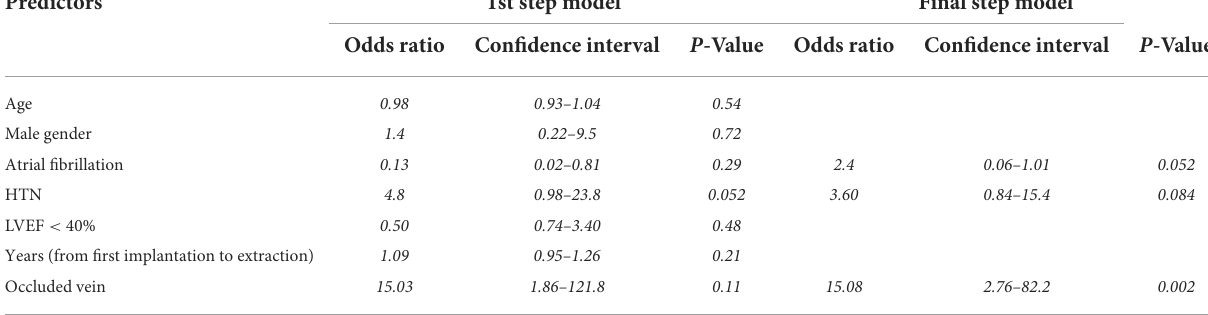
TABLE 5 Multivariable regression (backward Wald) models of predictors for periprocedural complications and mortality.